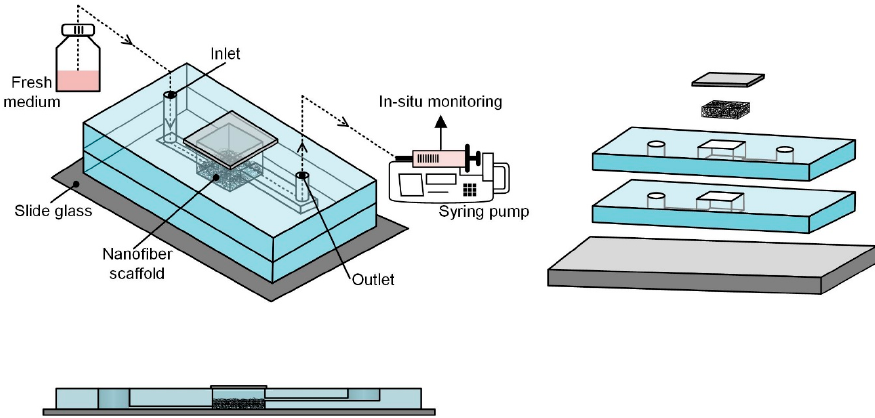
Figure 1. Concept of a microfluidic chip with a nanofiber scaffold.